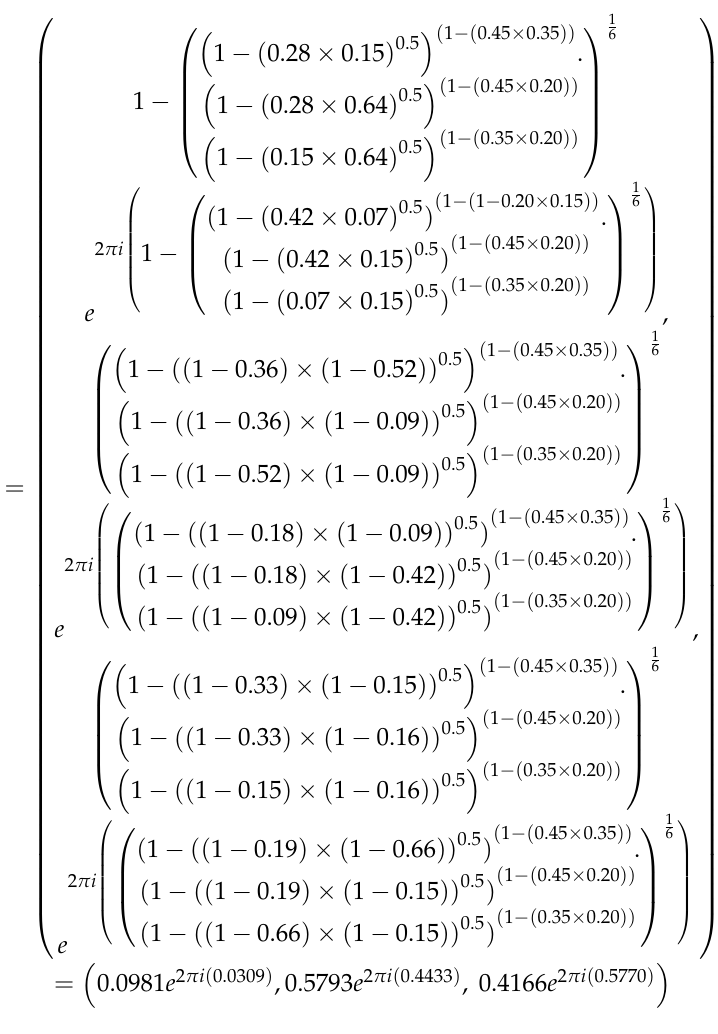
Table 1. Symbols and their